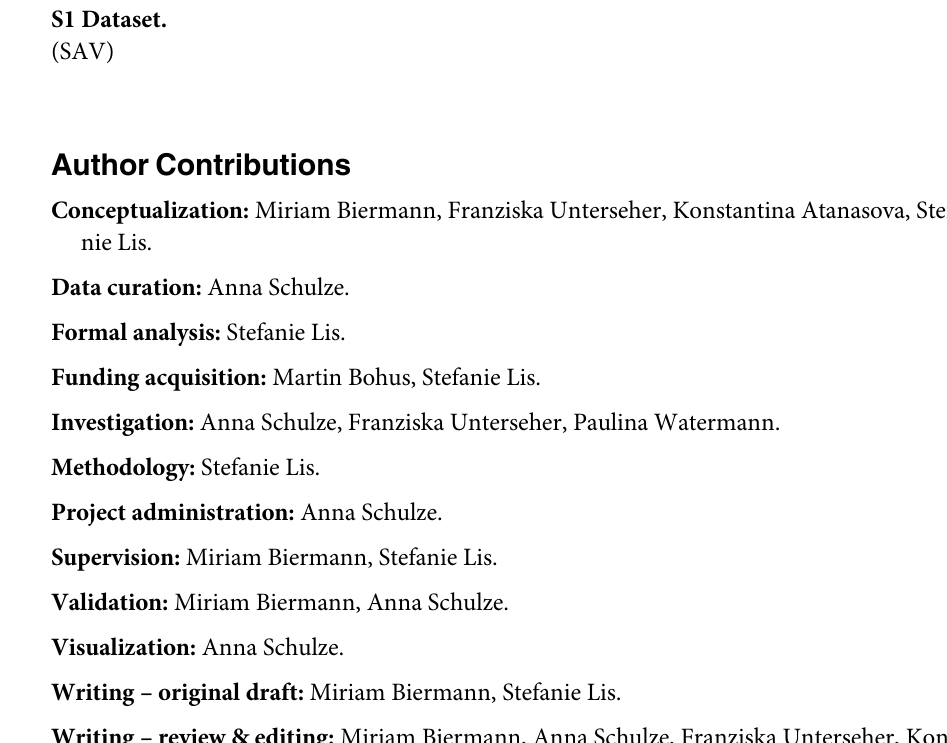
S2 Table. Spearman Correlations between pandemic-related